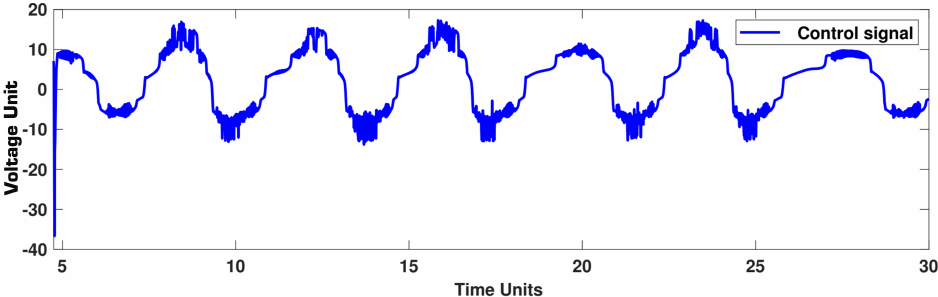
Figure 15. Example 3: Control signal, faulty condition.